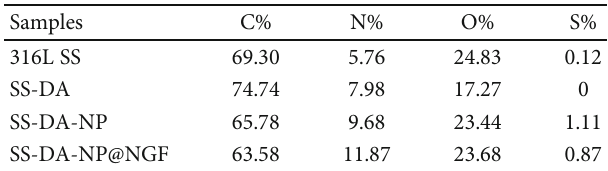
Table 2: Surface elemental composition determined by XPS.